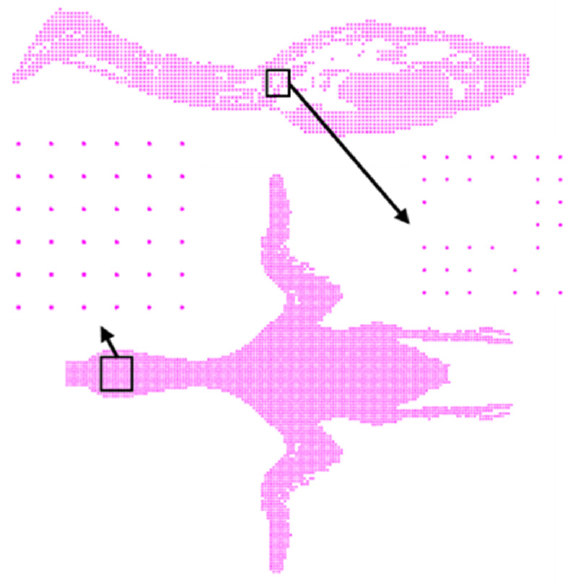
Figure 1. The SPH model of the mallard. According to previous studies [27], birds behave similarly to fluids during high-speed impacts where the inhomogeneity and nonuniformity due to other components such as feathers and bones can be neglected. Based on this assumption that all parts of the bird body exhibit the same mechanical behavior, a single material model can effectively predict the impact behavior of the bird body under different conditions [18]. To simulate this material behavior of the bird body, a material model accompanied with an equation of states (EOS) is usually used. The null material model is often used to simulate fluids in high-velocity conditions. The strain of the fluid could be related to its stress by: